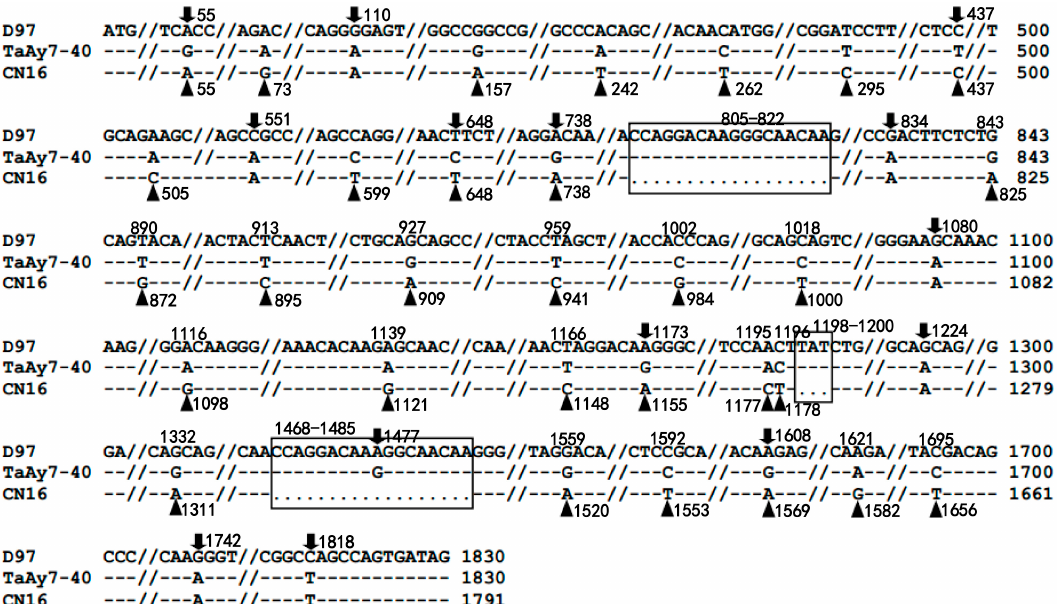
Figure 4. Identification of single nucleotide polymorphisms (SNPs) and insertions and deletions (InDels) of 1Ay nucleotide sequences in D97 (KC545956), TaAy7-40 (KC545952), and CN16 (KC545955). Triangles mean the different SNPs between CN16 and TaAy7-40; the down arrows indicate the different SNPs between D97 and TaAy7-40; the boxes represent the